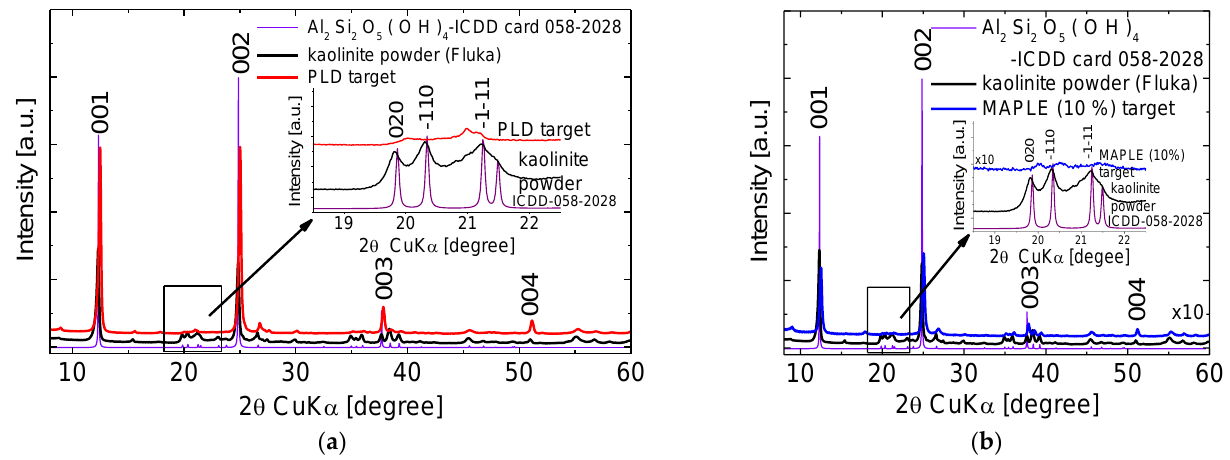
Figure 3. XRD patterns of the kaolinite commercial powder, (a) PLD target and (b) MAPLE target. There is a large number of studies on the structure and proper definition of order and disorder in clays crystal structures [29]. The term of crystallinity is to be rather avoided in connection with clays and other parameters were introduced to describe the variety of order or disorder forms occurring in phyllosilicates [30]. We calculated two of such order-disorder indexes: the Hinckley index (HI), the most widely used, allowing a semi-quantitative evaluation of the degree of order-disorder of the kaolinite lattice, which was proposed in 1963 [31] and the Aparacio-Galan-Ferrel index (AGFI) proposed in 2006 [32]. In both cases, the indexes are determined by using reflections in the range 19 ◦ to 23 ◦ 2 θ , considered to be sensitive to the structural defects as random and interlayer displacements. The HI includes the background in the calculation while, AGFI only the peaks intensities, which allows a higher degree of confidence. Values of HI < 0.5 and AGFI < 0.90 designates a disordered kaolinite while HI > 1.5 and AGFI >1.6 [29,30] characterizes an ordered kaolinite. FWHM-001 (F1) and FWHM-002 (F2) indexes determined as the width at half height of the basal reflections of kaolinite, (001) and (002), are the only one derived from oriented aggregates. Values (in degree) range from >0.4 (disordered) to <0.3 (ordered) [29]. The crystallite size D 001 obtained from FWHM-001 through the Scherrer formula describes the thickness of coherent diffraction domain along the c -axis, which is the stacking axis of platy phyllosilicate layers. Awad et al. [33] found correlations between the crystallite size D 001 of 28 kaolinite samples and their HI order-disordered index.